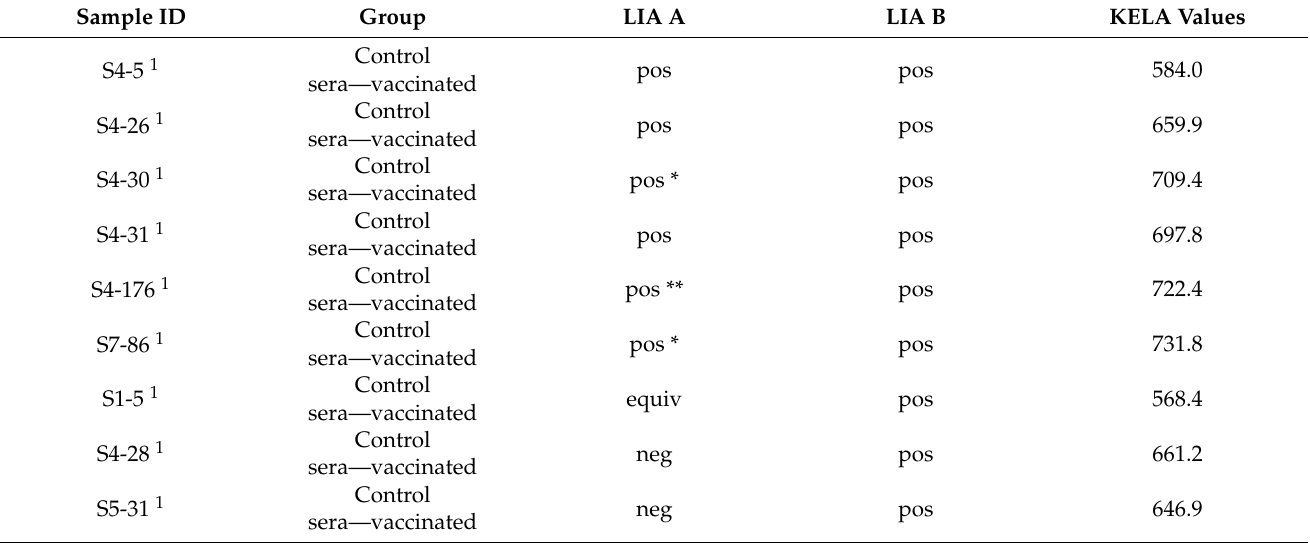
Table 9. Equine serum samples with OspA AG signals and results considered “pos” on LIA B due to the recognition of ≥ 4 AG lines (beside VlsE and OspA) that are considered as non-specific for an infection with Bb sl complex species in vaccinated